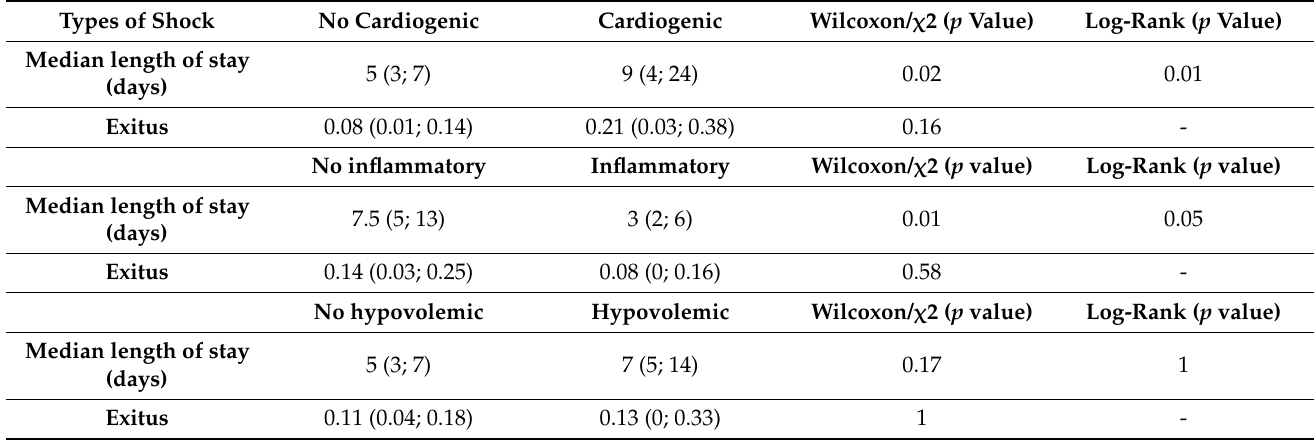
Table 1. Association between each type of shock and both length of stay and